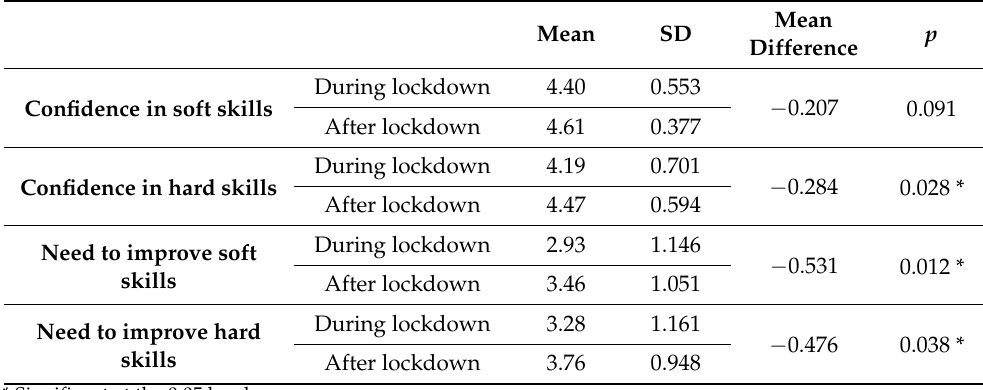
Table 4. Comparison of self-evaluation and perceived need to improve soft and hard skills—during and after